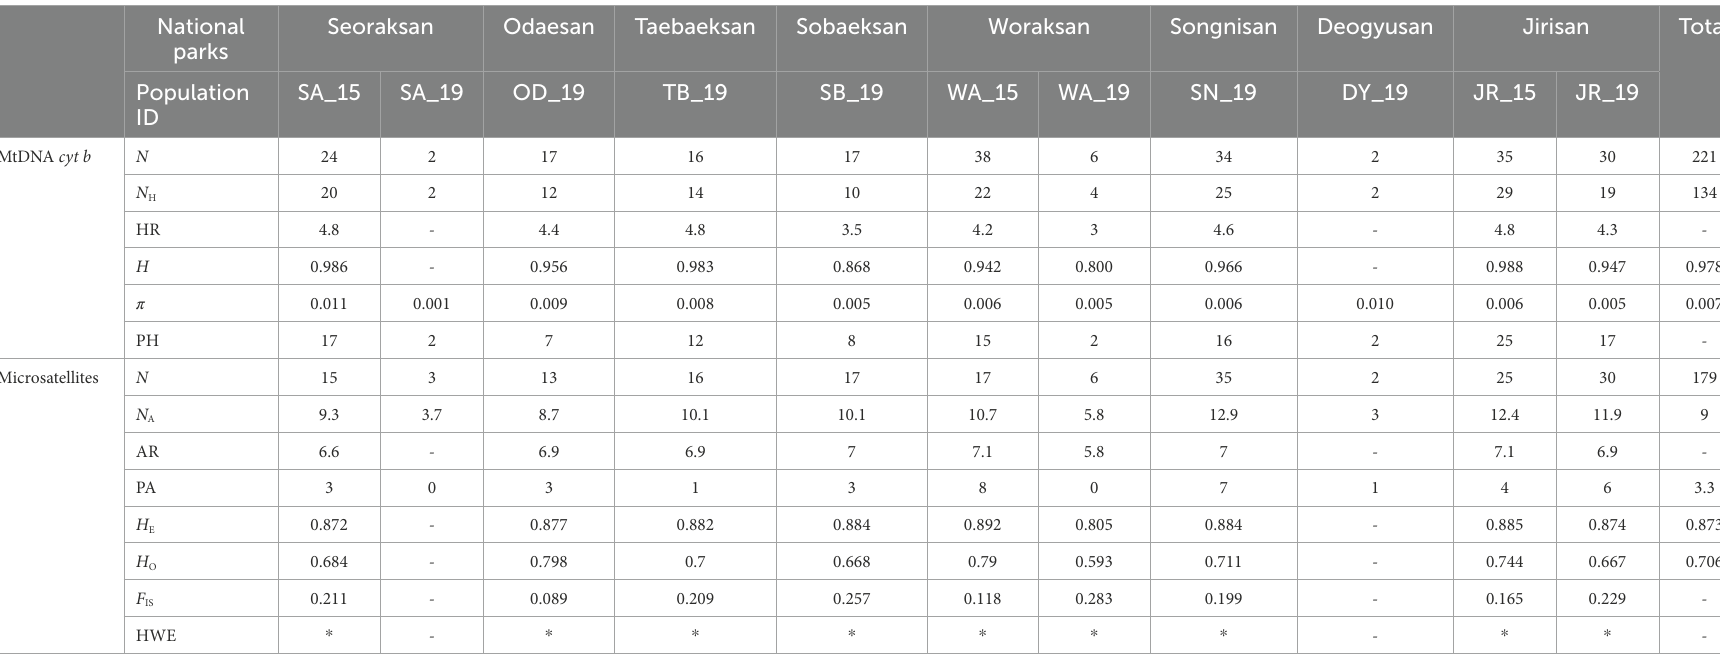
TABLE 1 Summary of genetic diversity statistics in 11 populations (including three temporal samples) of Apodemus agrarius in eight national parks within the Baekdudaegan Mountain Range (BMR) in South Korea at both mtDNA cyt b and nine microsatellite loci. The numbers 15 and 19 for population ID indicate sampling years of 2015 and 2019,